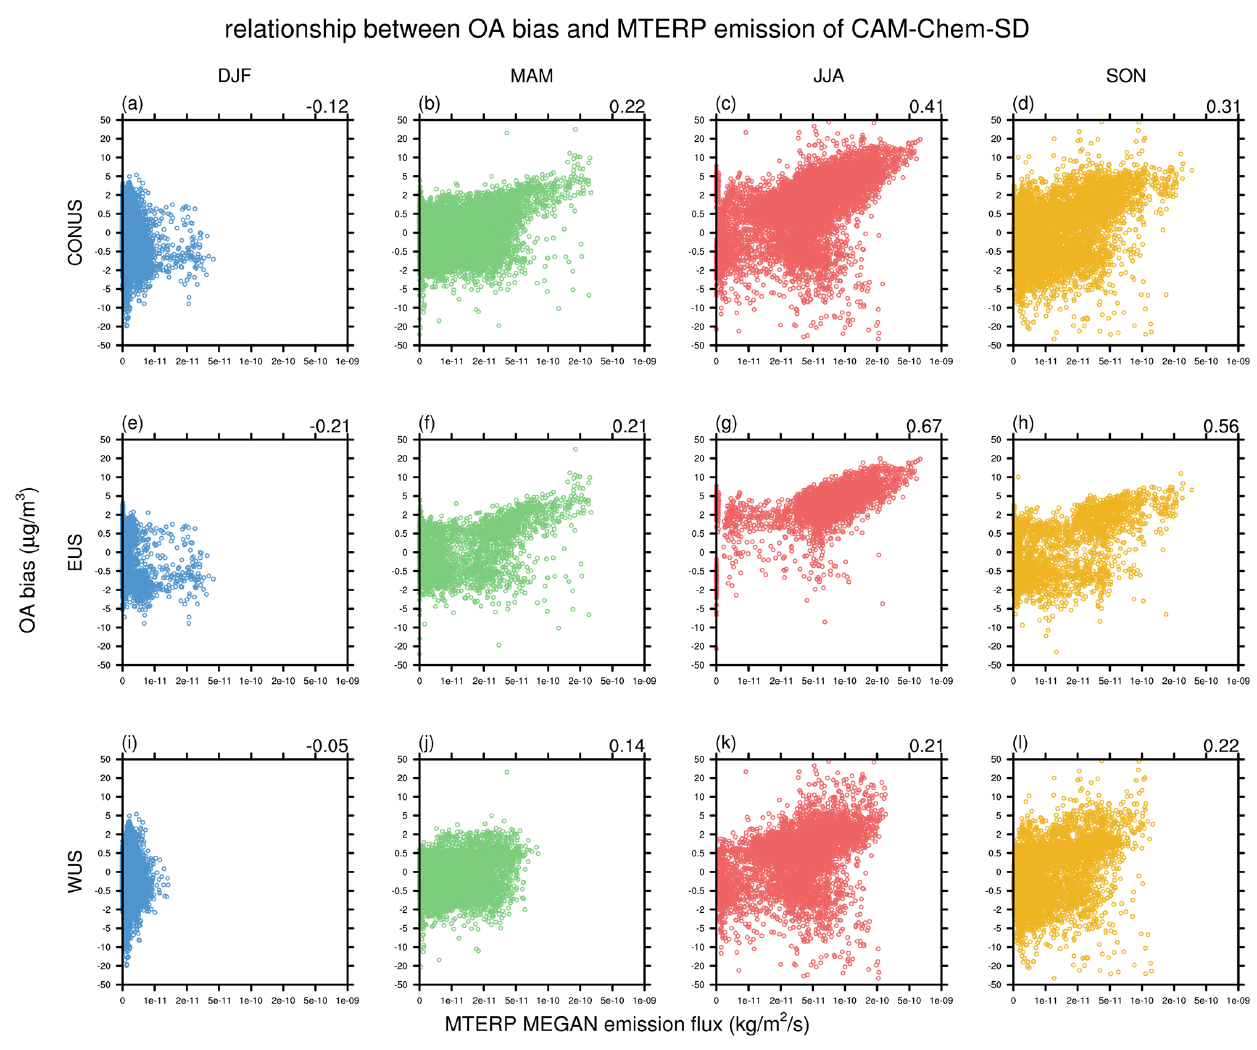
Figure 5. The relationship between simulated surface OA bias ( y axis) and surface MTERP emissions ( x axis) in December–February (DJF) (a, e, i) , March–May (MAM) (b, f, j) , June–August (JJA) (c, g, k) , and September–November (SON) (d, h, l) over CONUS (a–d) , EUS (e–h) , and WUS (i–l) . The correlation coefficient of OA bias and MTERP emission is shown as the number in the top right of each